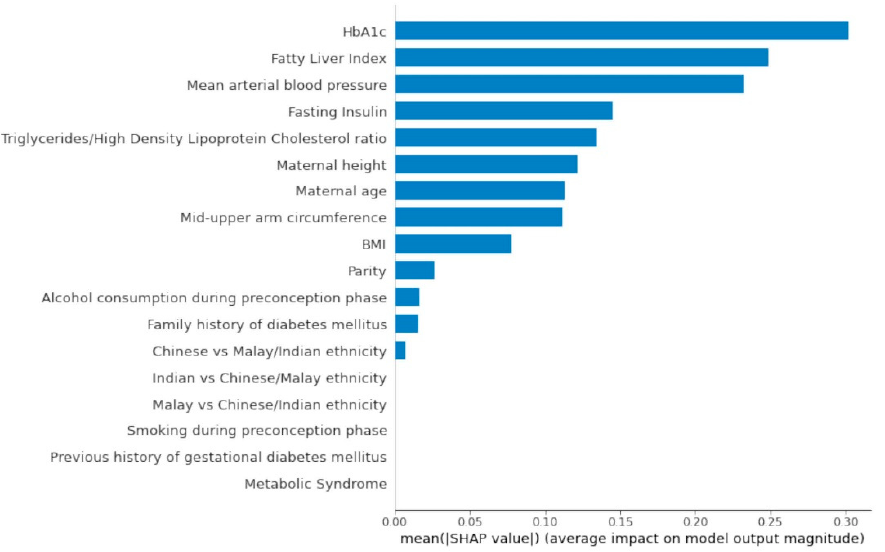
Figure 2. SHAP Global Importance Plot. Global importance of individual features and their correla- tion with GDM/non-GDM outcomes estimated using the Shapley values computed from coalitional game theory. SHAP values represent a change in log odds ratio. SHAP values of zero means that the feature does not contribute to the prediction.